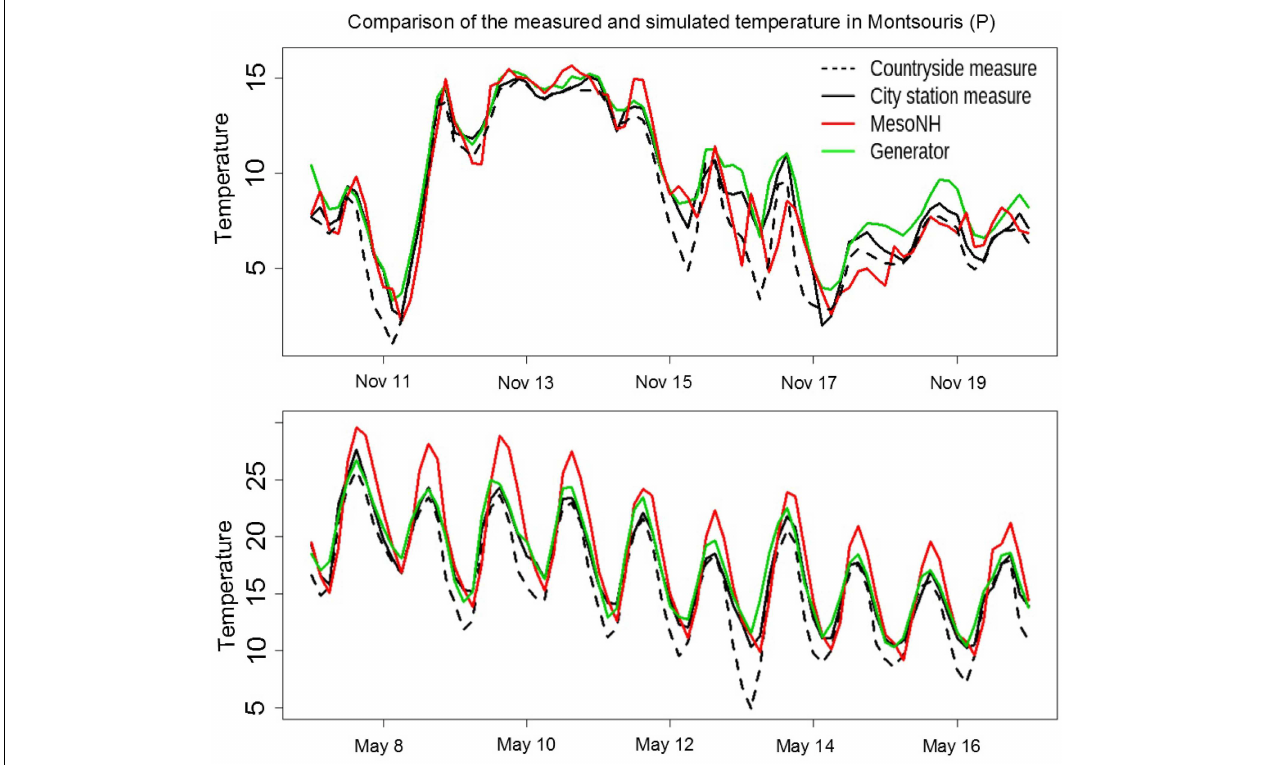
FIGURE 12 | Temporal evolution of the temperature measured in the countryside (in black dashed lines), in the city at the Montsouris station (in black), simulated by the generator (in green) and by MesoNH (in red) in November and May.